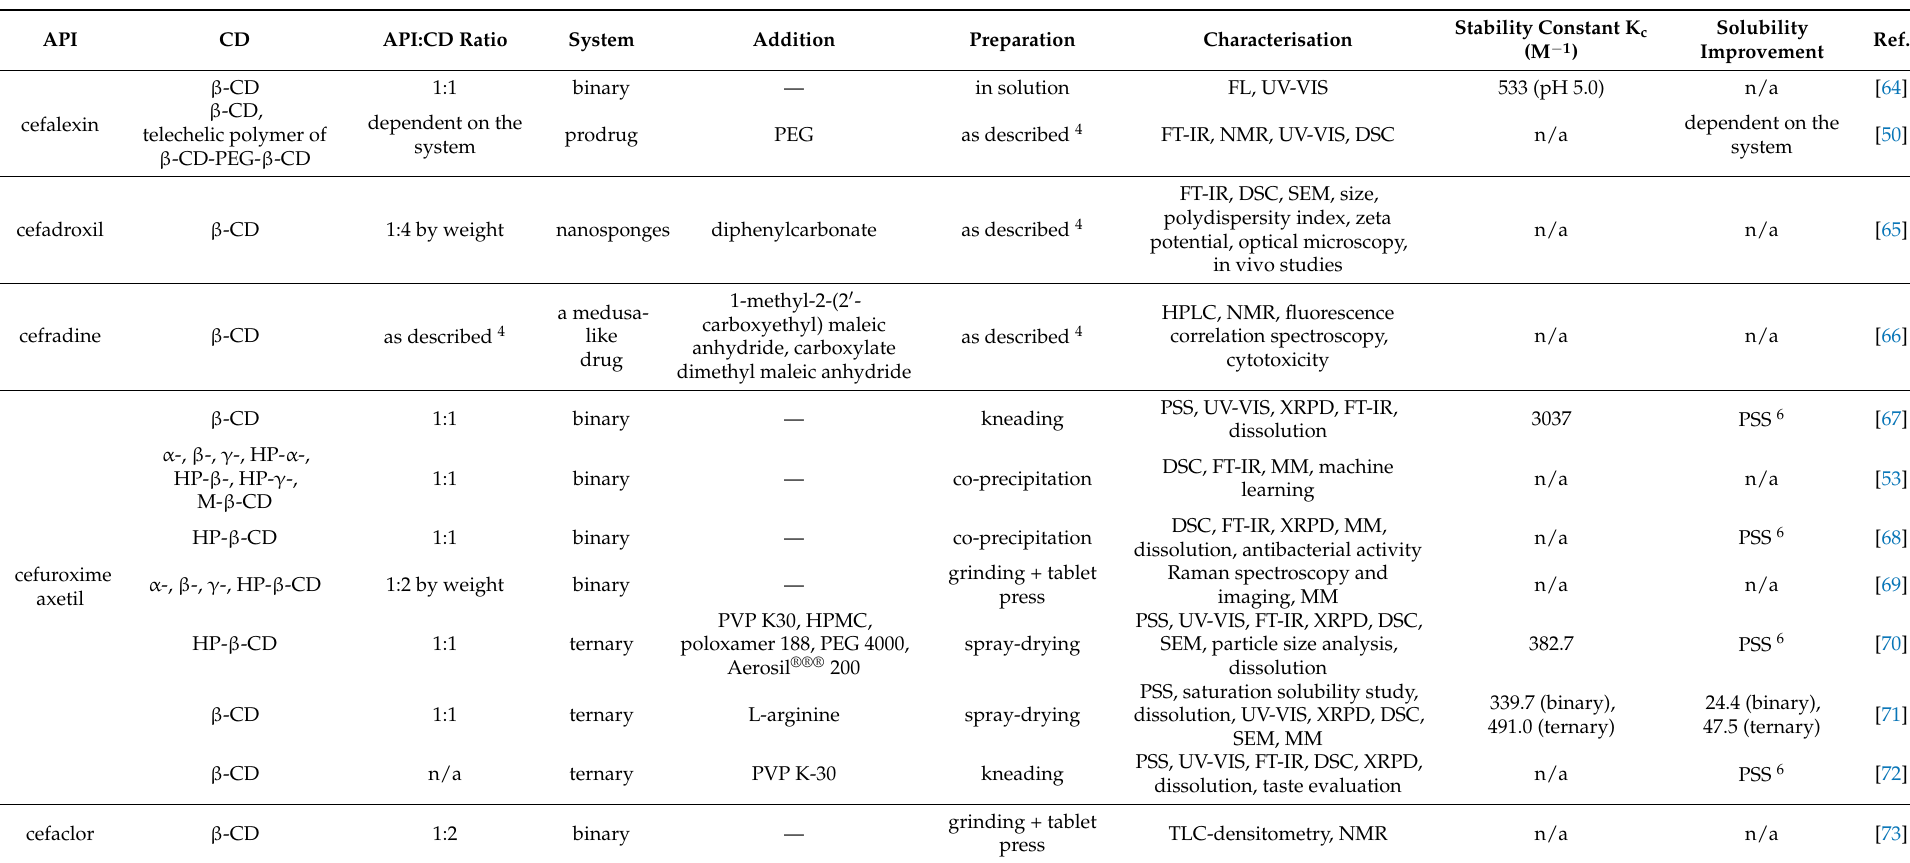
Table 2. Detailed information of cephalosporin complexes on the types of CDs used, methods of complex preparation, and techniques used to characterise the obtained products